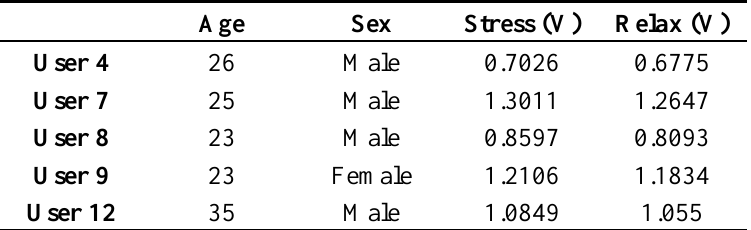
Table 15. Mean values of the SCR from Stroop test.